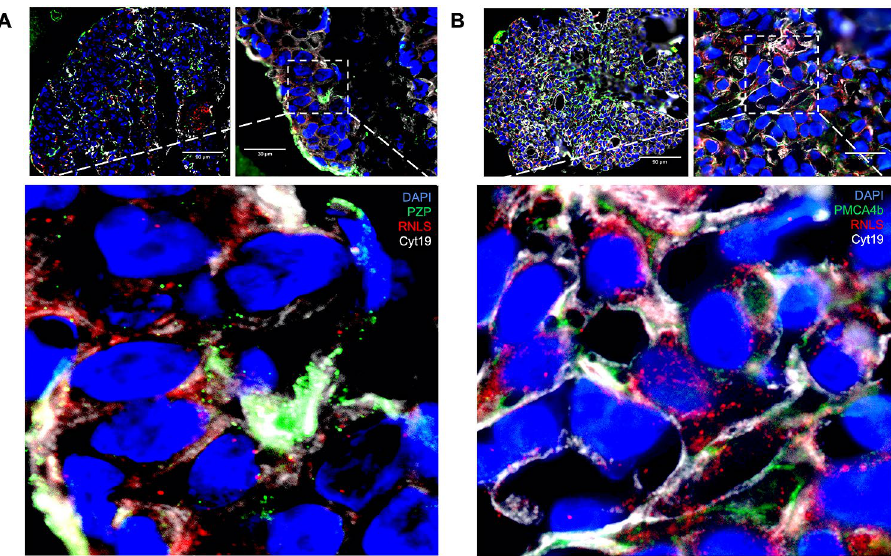
Figure 7. Placental villi organoids express RNLS, its receptor PMCA4b, and the RNLS carrier protein, PZP. (A) Immunofluorescence co-staining with RNLS (red), PZP (green), DAPI (blue), and Cyt19 (white) of placental villi organoid at 20x and 60x. (B) Immunofluorescence co-staining with RNLS (red), PMCA4b (green), DAPI (blue), and Cyt19 (white) at 20x and